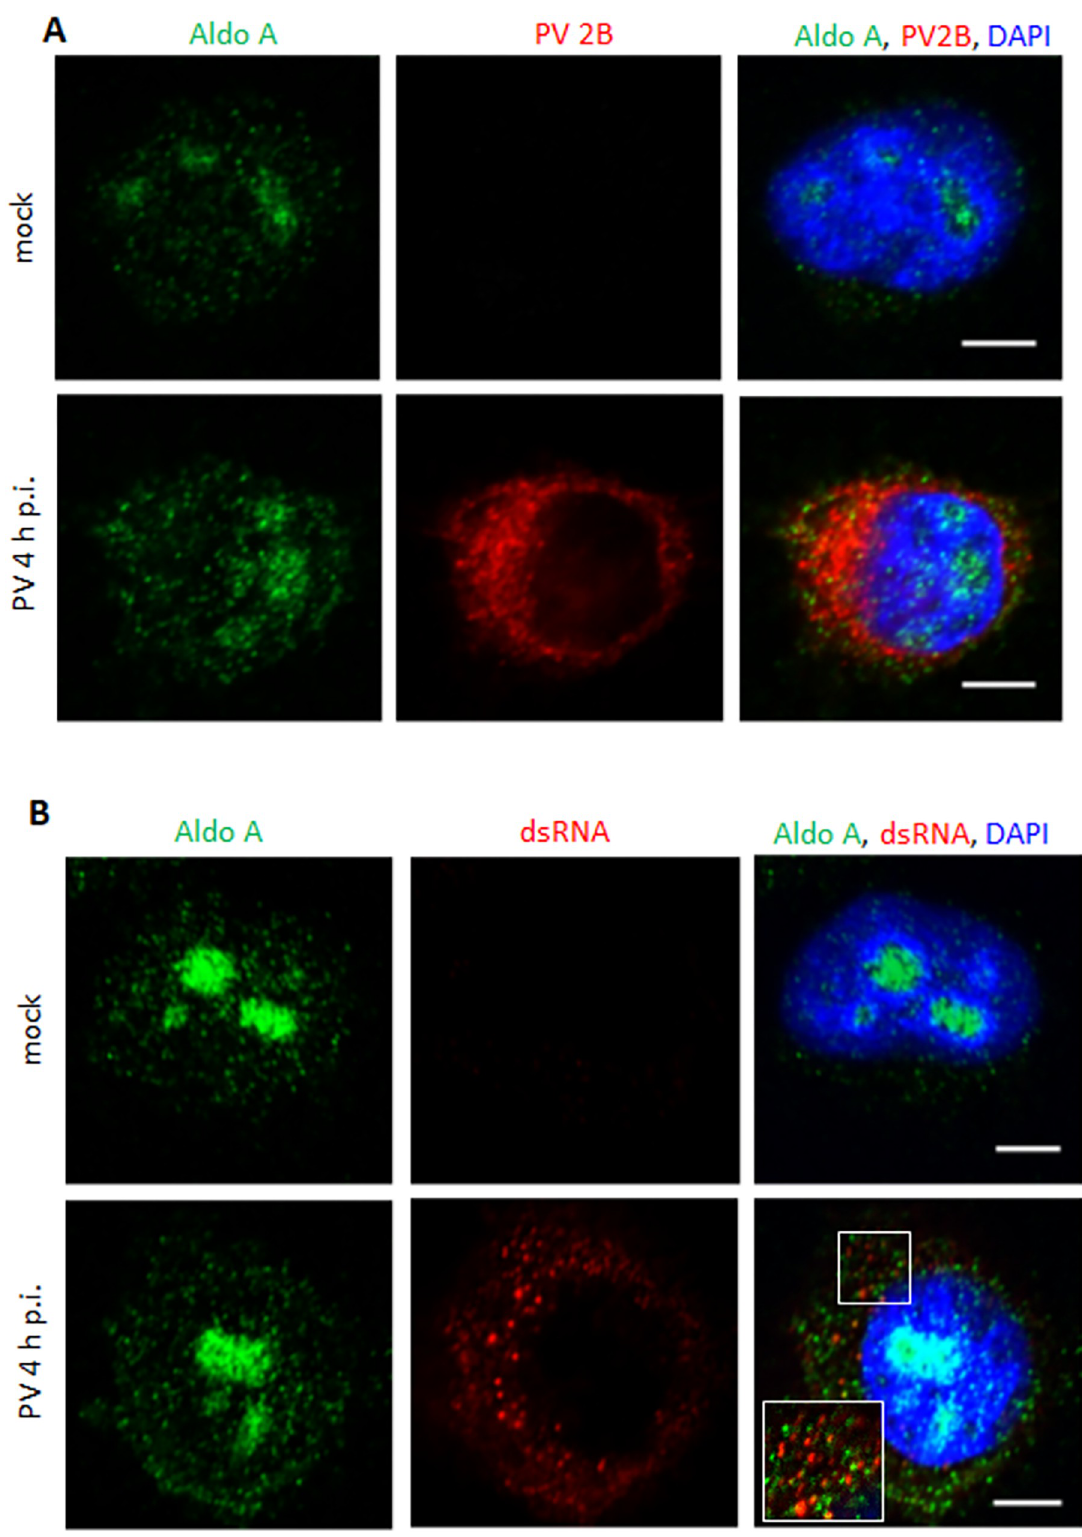
Fig 6. AldoA localization in infected and mock-infected cells. A, B . Confocal images of HeLa cells infected (or mock-infected) with 10 PFU/cell of poliovirus, fixed at 4 h p.i. and stained with antibodies against AldoA and a viral antigen 2B (A), or AldoA and dsRNA (B). Scale bar is 10 μ